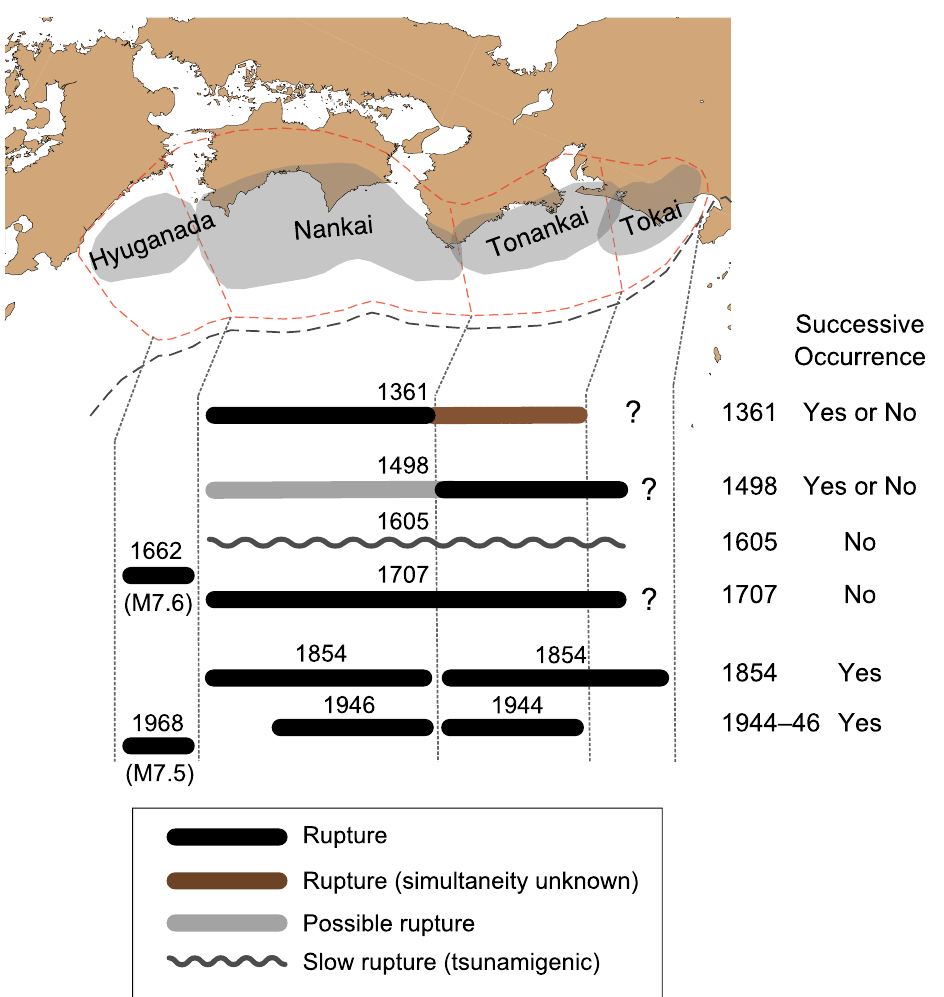
Figure 3. Extent of rupture of past Nankai megathrust earthquakes. The black and brown bars indicate the approximate extent of rupture in the indicated years. The grey bar indicates either separate rupture, simultaneous rupture with the eastern segments, or no rupture. The question marks indicate that the rupture extent is